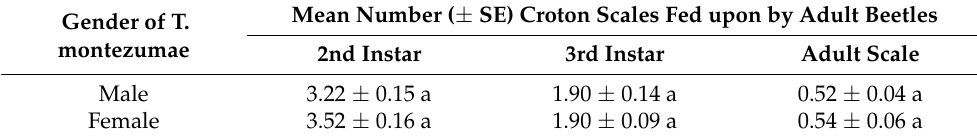
Table 2. Feeding of adult T. montezumae on different life stages of P. howertoni over 24 h. Mean Number ( ± SE) Croton Scales Fed upon by Adult Beetles Gender of T. montezumae